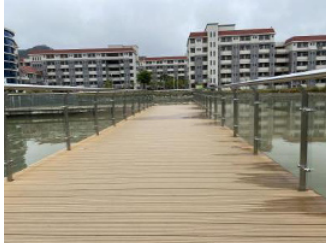
Fig. 3. Solid wood-plastic composite decking.